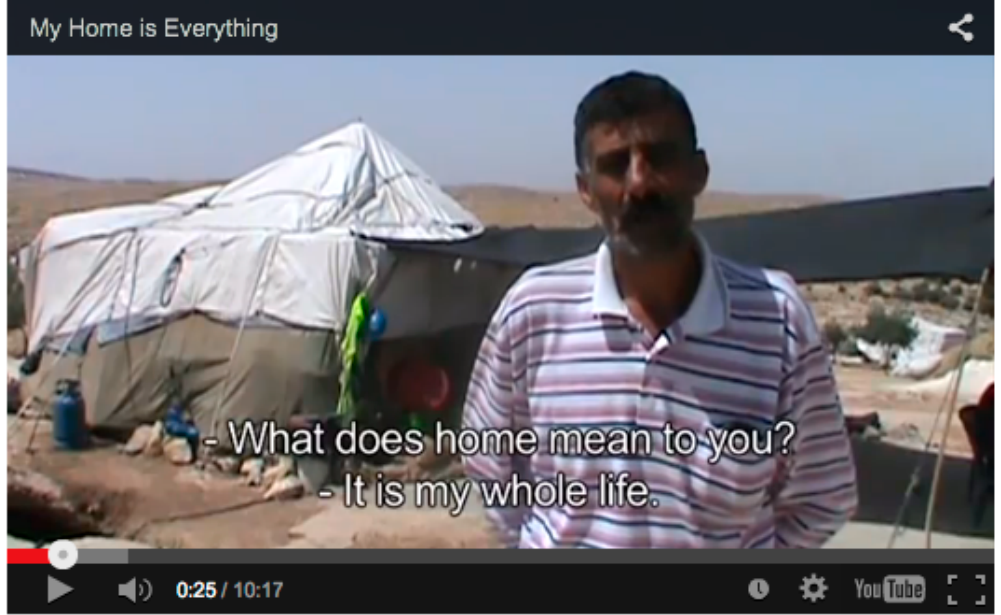
Figure 9. YouTube screen grab of Nawaja’s video project (Accessed on 19 July 2016).